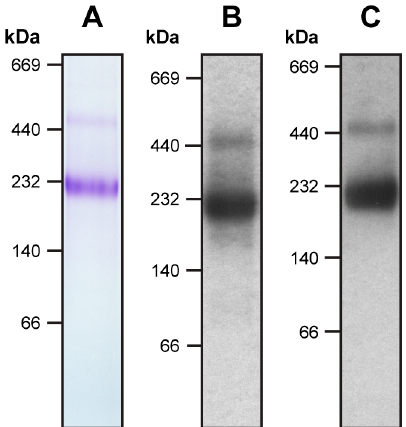
Figure 1. Blue native-PAGE and Western blot analysis of purified human 4F2hc-LAT2 heterodimeric complex. Panel ( A ) displays a Coomassie Brilliant Blue stained 4-16% gradient blue-native gel of purified 4F2hc-LAT2. Western blot analyses using anti-His ( B ) and anti-Strep antibodies ( C ) indicate purity and correct assembly of the complex. The heterodimeric complex migrates to about 230 kDa. The faint band above the 440 kDa marker is in good agreement with a dimer of the heterodimeric complex, possibly due to unspecific aggregation. Note that neither monomeric 4F2hc nor monomeric LAT2 are present in the sample. Five micrograms of purified protein was loaded per lane.